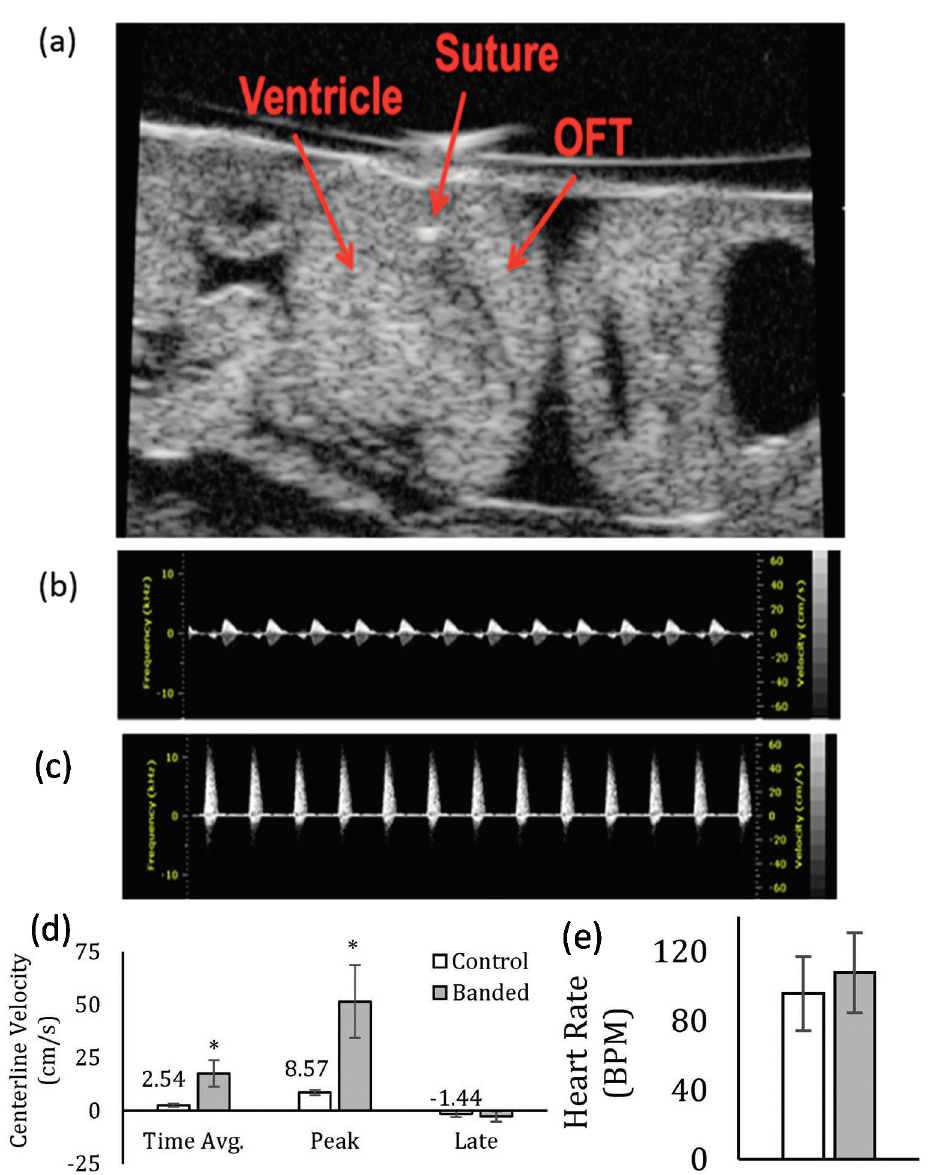
Figure 2. Ultrasound imaging. ( a ) B mode of a banded embryo showing the suture at the ventricle junction (OVJ). Pulsed-wave Doppler (PWD) at the OVJ for the ( b ) control and ( c ) banded hearts; ( d ) OFT banding caused significant changes in the time-averaged (avg) and peak centerline velocities, but not for velocities measured late in the cardiac cycle during retrograde flow measured at the OVJ; ( e ) the heart rate remained unchanged between controls and banded chick hearts. * p <